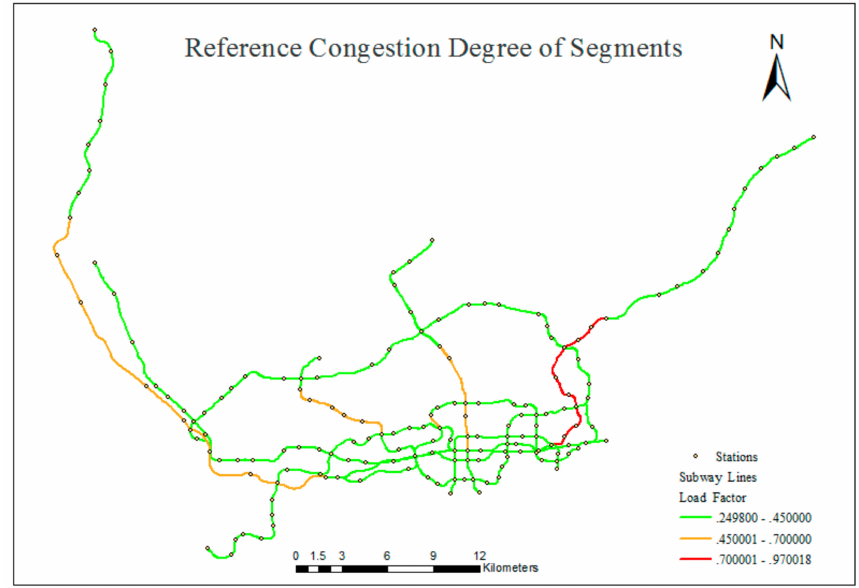
Figure 11. Reference degree of congestion of the subway